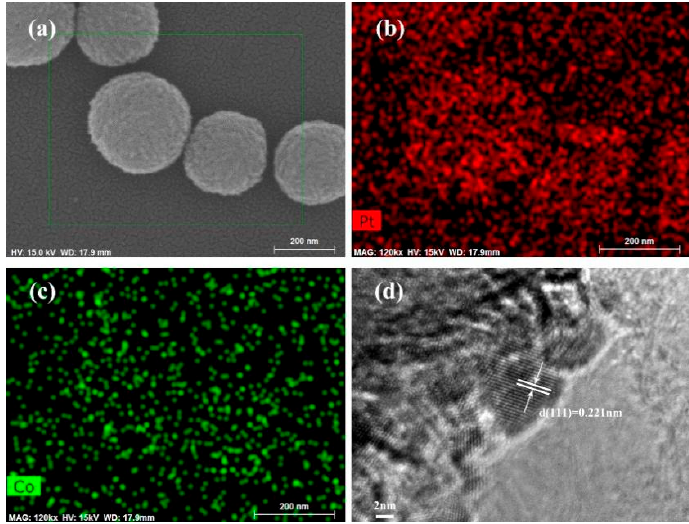
Figure 4. EDS mapping images of the MoS 2 /PtCo-alloy NP composites. ( a ) Mapping area of SEM image; ( b ) element mapping of Pt; ( c ) element mapping of Co; ( d ) HRTEM image of PtCo-alloy NPs.